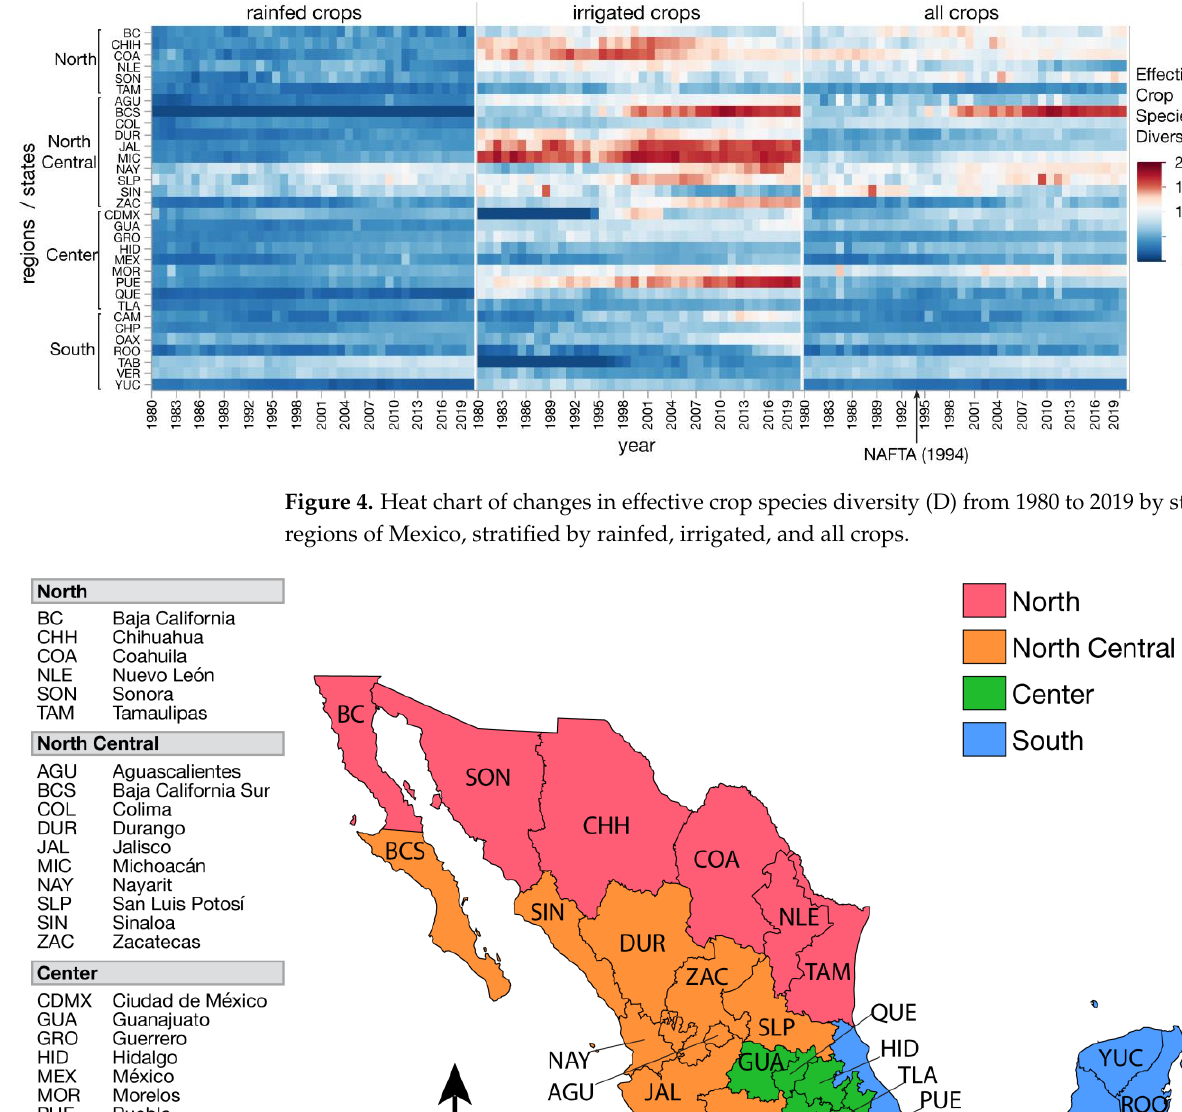
Figure 5. States and regions of Mexico.